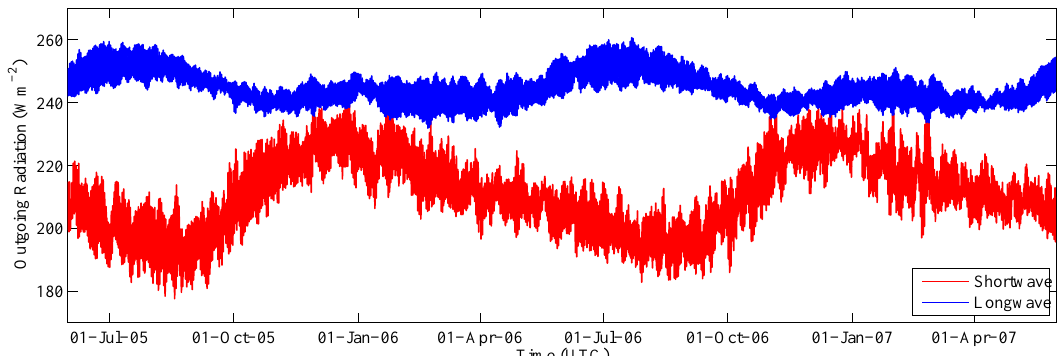
Figure 4. Time series of outgoing longwave and shortwave radiation produced by the GEOS-5 Nature Run. The time series covers a two-year period from 1 June 2005 to 1 June